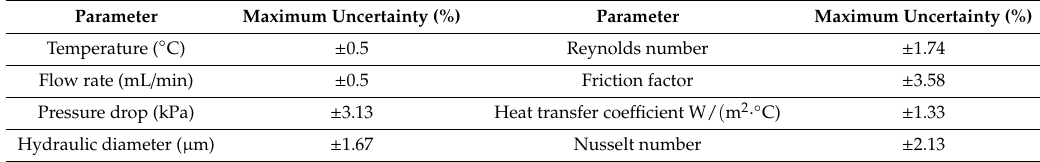
Table 1. Parameters and estimated